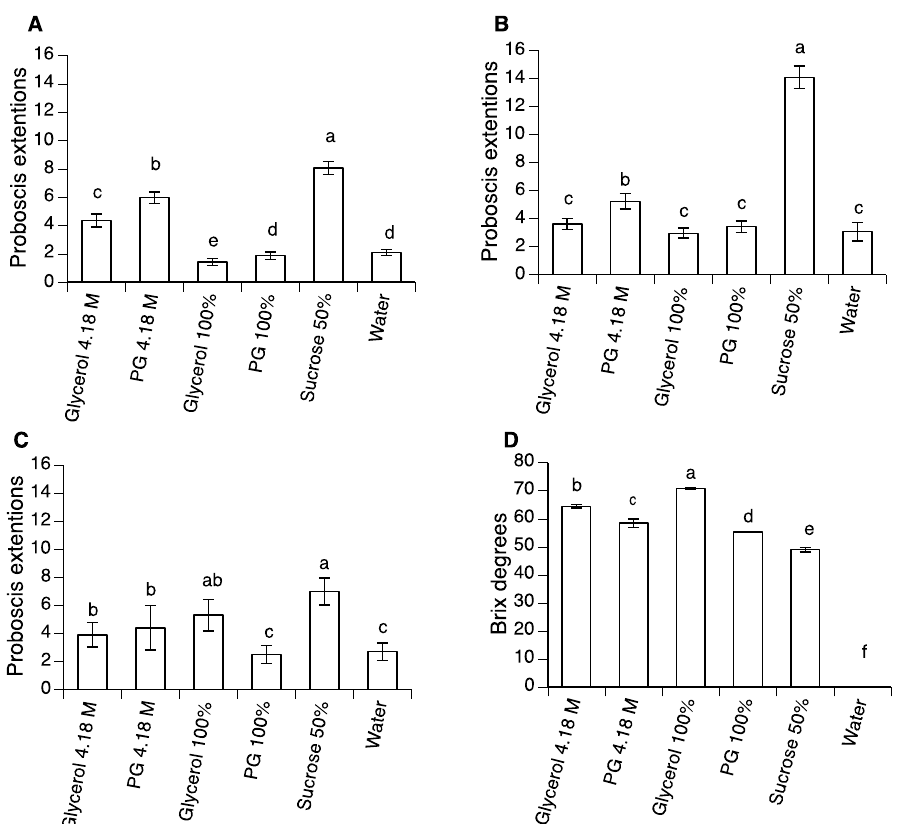
Figure 5. Mean ( ± SE) number of proboscis extension responses observed by adults of ( A ) A. ludens , ( B ) A. obliqua , and ( C ) D. suzukii following five exposures to 4.18 M or 100% PG or glycerol. ( D ) Refractivity readings (Brix) of 4.18 M or 100% PG or glycerol. Columns headed by identical letters are not significantly different (contrast for GLM, or Tukey test for ANOVA at p > 0.05).